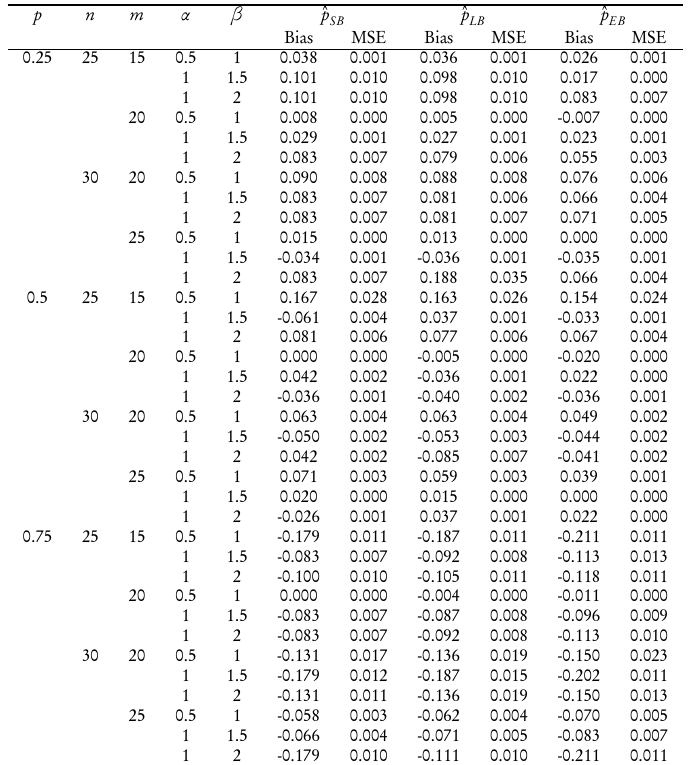
for different choices n, m, α , β and p = 0.25, 0.5 and EB